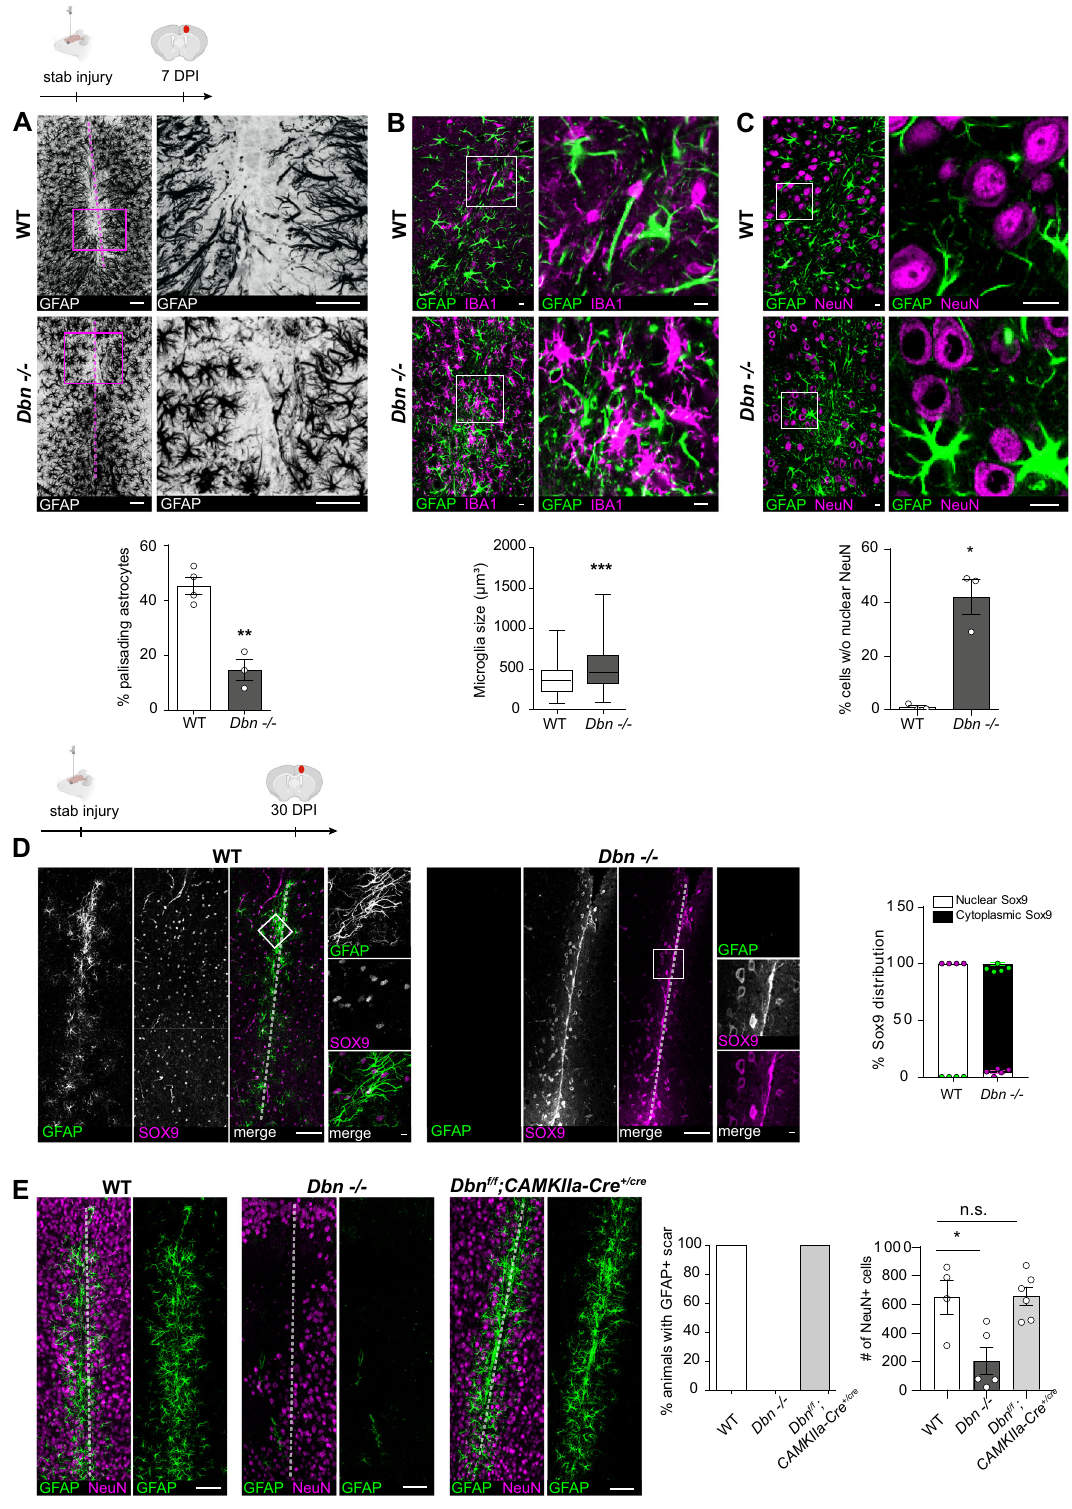
animals consistently show typical GFAP + astrocytes with SOX9 + nuclei in lesions, with no signs of NeuN translocation after seven days of injury or NeuN loss 30 days after stab injury (Figure S3A, S4C, Fig. 2E). In summary, DBN is essential for astrocyte reactivity and damage containment during traumatic brain injury. DBN-loss perturbs injury-induced scar formation and suppresses maintenance of astrocyte reactivity, providing a